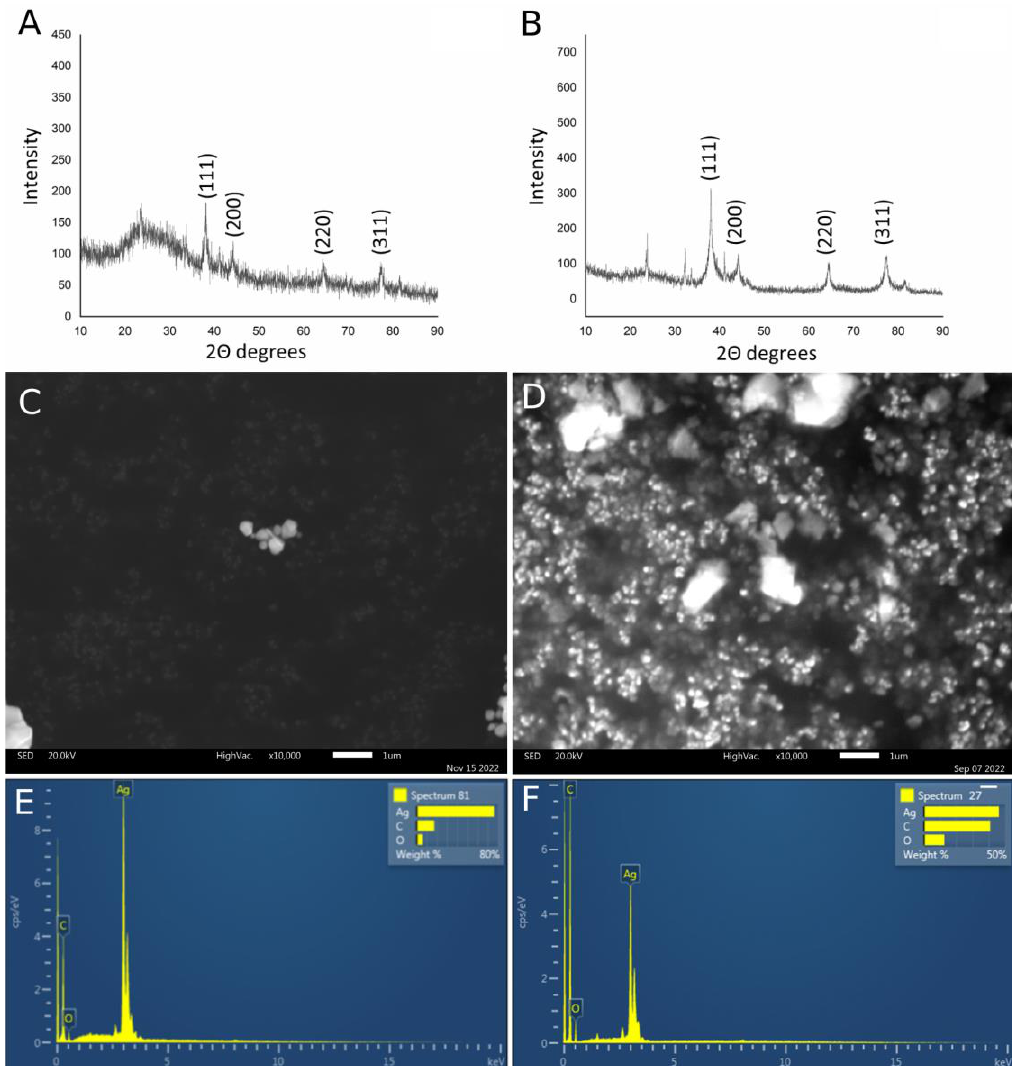
Figure 4. Characterization of AgNPs synthesized using S. pratensis extracts using various analytical techniques. XRPD spectrum of ( A ) SPA-AgNPs and ( B ) SPR-AgNPs; SEM images of ( C ) SPA-AgNPs and ( D ) SPR-AgNPs and their corresponding EDS spectra ( E and F , respectively).